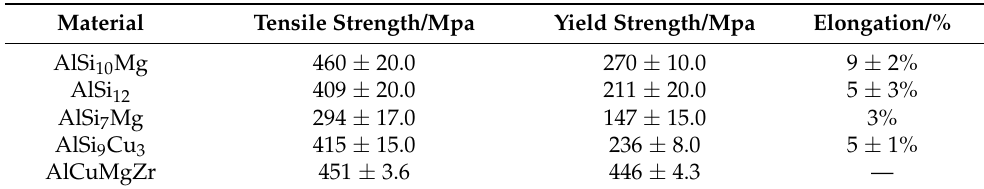
Figure 8. Aluminum alloy parts produced by SLM [52]. Table 2. Grades and principal properties of aluminum alloy powder materials required for additive manufacturing .